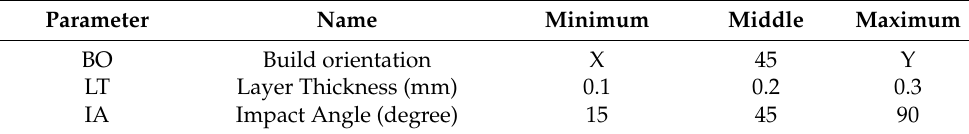
Table 1. Taguchi’s L9 array of parameters and their levels considered for the experimentation.